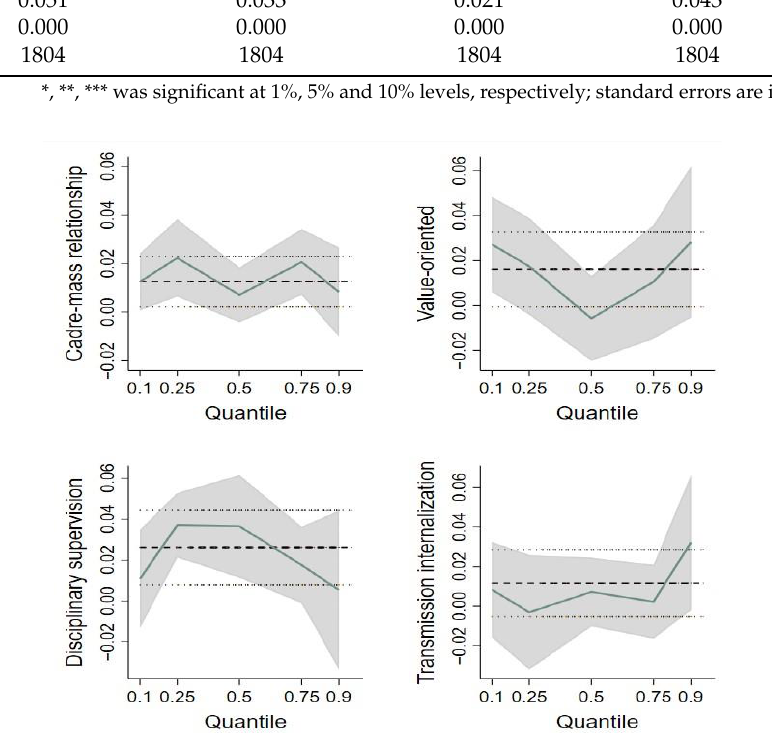
Figure 2. The trend of quantile regression. Note: The thick dashed line in the middle represents the OLS regression result of each variable, and the two thinner dashed horizontal lines represent confidence intervals for OLS regression results (95% confidence); The solid line represents the quantile regression results for each variable; The gray shading shows the confidence interval (95% confidence level) of the quantile regression results.